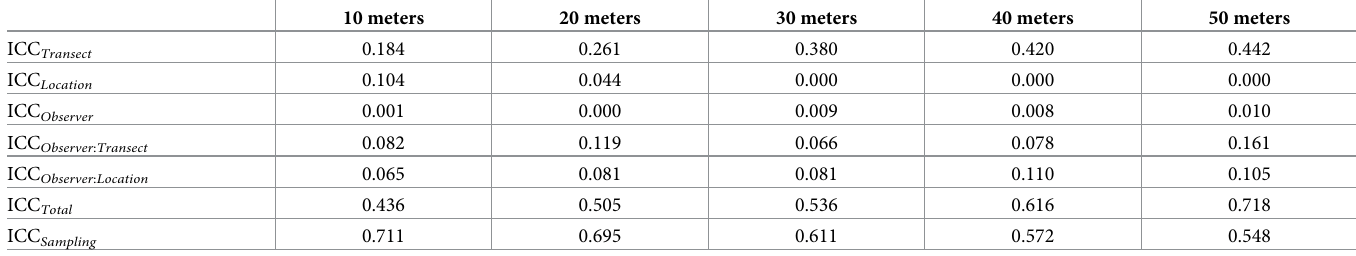
Table 3. Model of the observed Shannon diversity. Model output (ICC (Intraclass Correlation Coefficient) of the random effects, total ICC explained by the factors of the model and ICC associated with the sampling variability) for a linear mixed model with Shannon diversity as response, Island as fixed effect, Location and Transect as nested random effects and Observer as crossed random effect. Transect lengths of 10, 20, 30, 40 and 50 meters were